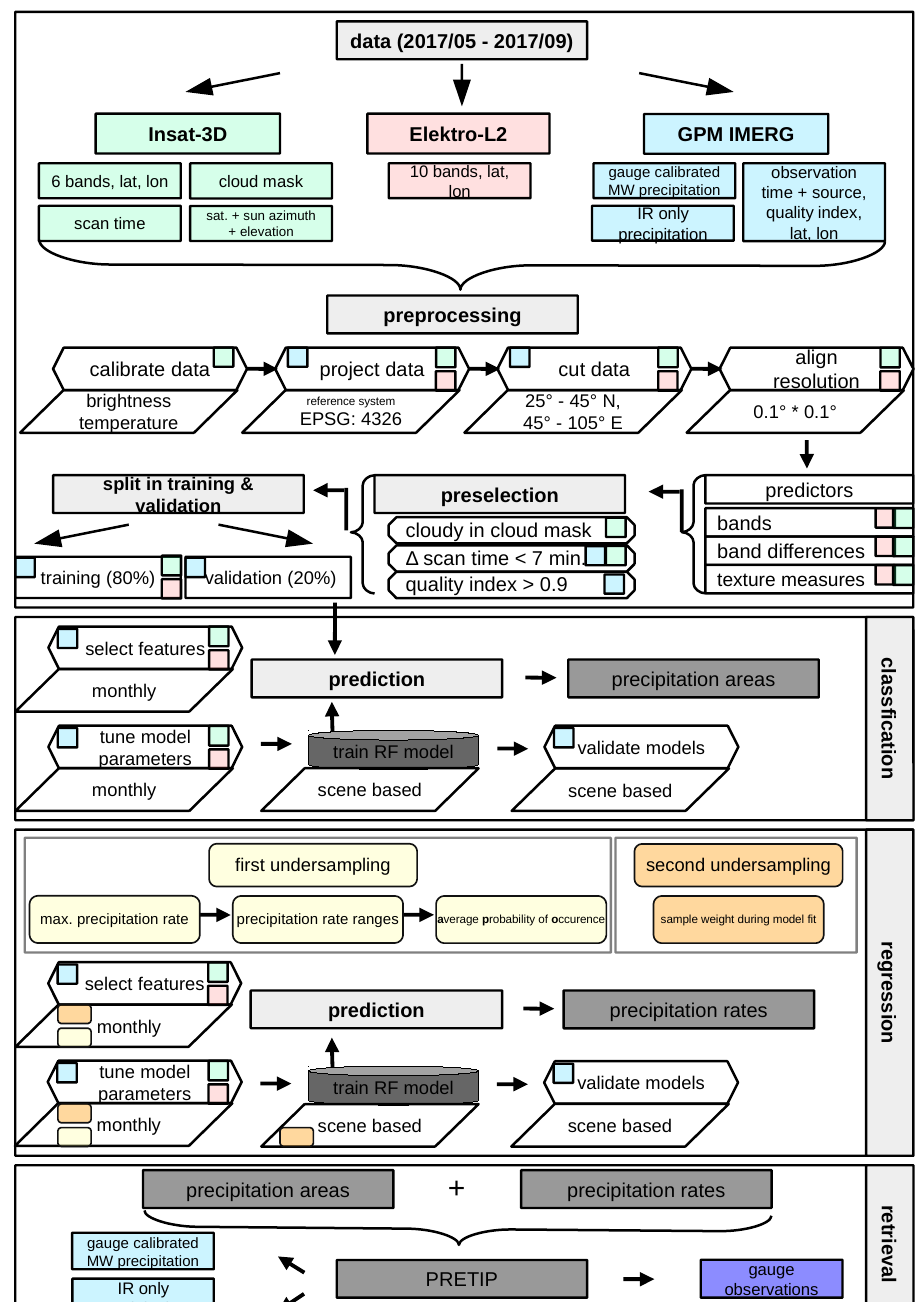
Figure 1. Processing scheme for the precipitation rates retrieval based on Elektro-L2, Insat-3D, and the gauge calibrated microwave (MW) precipitation from GPM IMERG. RF = Random Forest. PRETIP = Precipitation Retrieval covering the Tibetan Plateau. Modified and extended after Kolbe et al. [33]. We also validated our product against 28 daily gauge measurements from the Chinese Ministry of Water Resources. The gauge stations are evenly distributed around the south central TiP (see Figure 2). These data are available without any gaps and are completely independent from GPM IMERG to which most state weather services